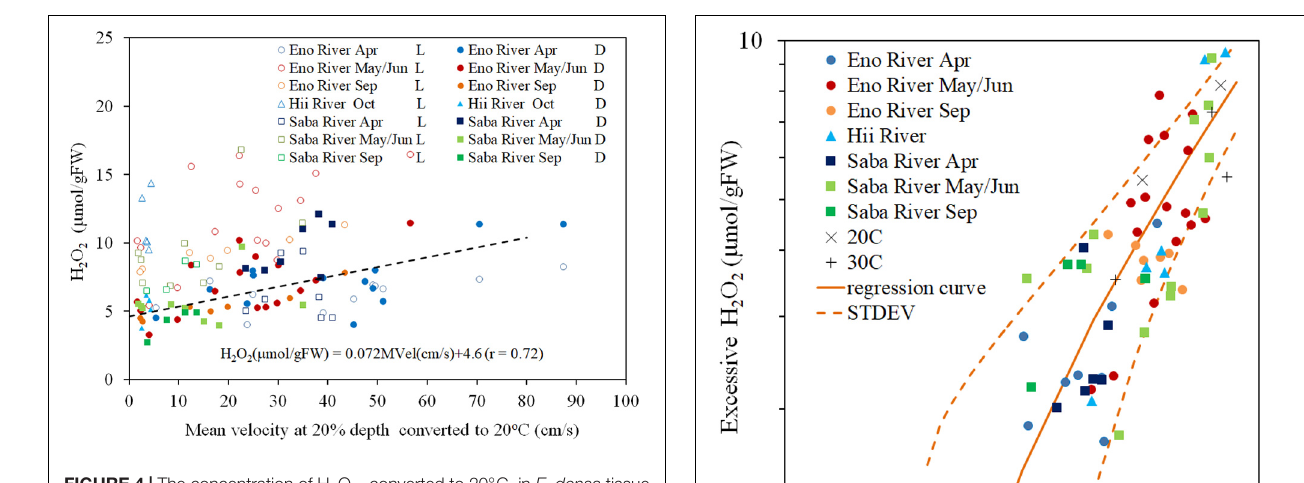
FIGURE 4 | The concentration of H 2 O 2 , converted to 20 ◦ C, in E . densa tissue as a function of the mean velocity at 20% deep thin light-exposed (L) and dark-adapted (D) conditions. The dashed line indicates the linear trend of the dark-adapted condition. The dates May, Sep (September), and Oct (October) represent data obtained in 2016 while Jun (June), Apr (April) represent data of 2017. Eno, Saba, and Hii represent Eno, Saba, and Hii rivers including their tributaries, respectively. H 2 O 2 is given in units of µ mol/gFW, and the MVel (mean velocity) is in cm/s.